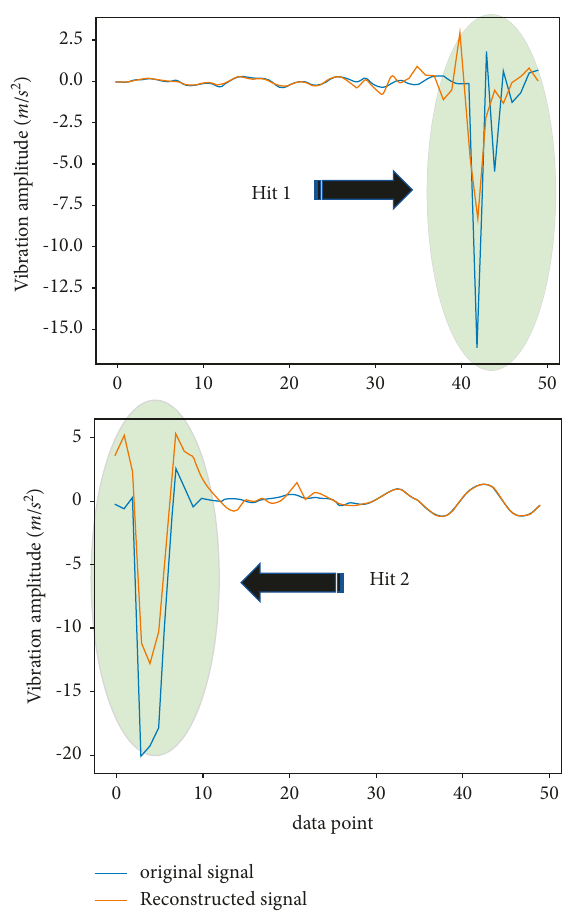
Figure 12: Reconstruction diagram of abnormal